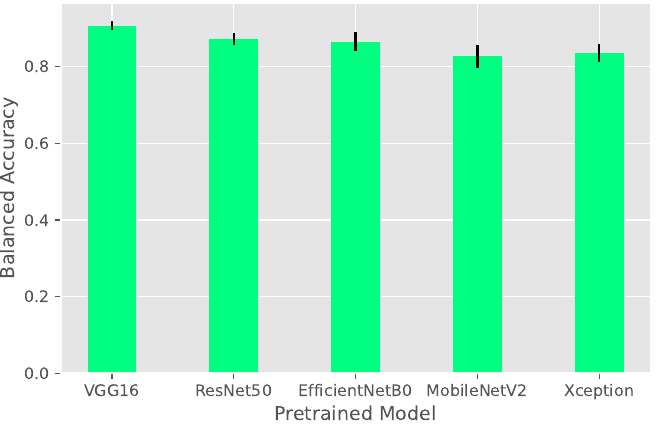
Figure 4. Comparison of different pre-trained models using the same input: repeat-based spectrogram. Here, VGG16 performs the best in terms of balanced accuracy.